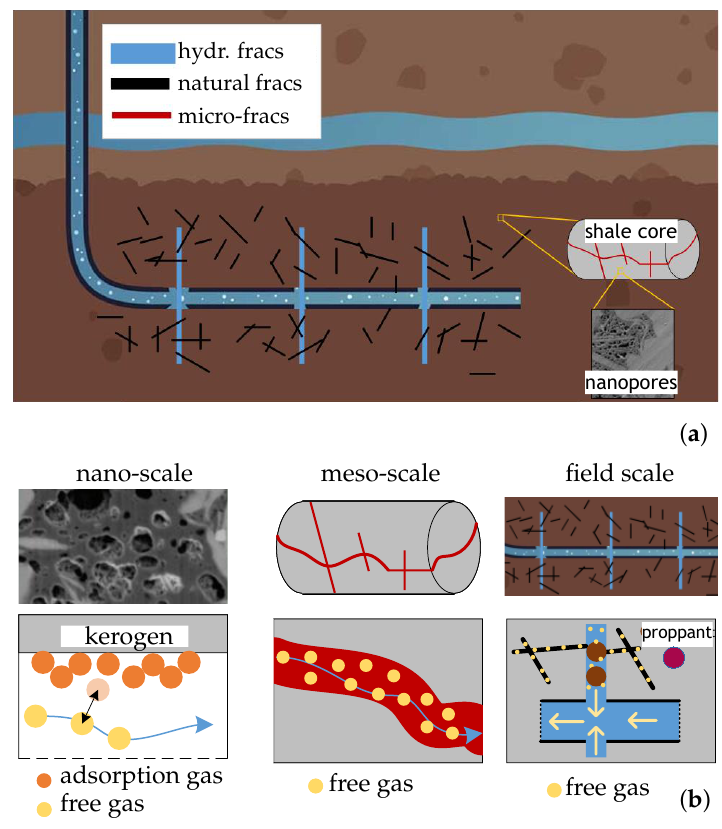
Figure 1. Shale gas production: ( a ) gas transport, ( b ) multiscale